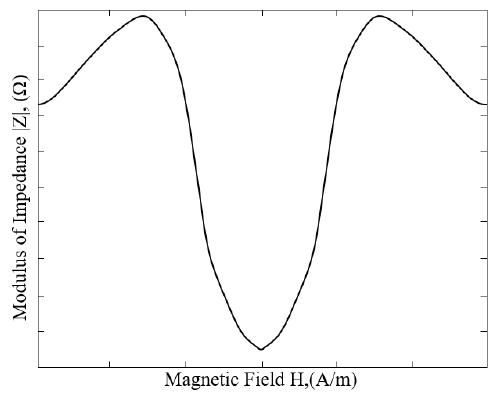
Figure 2. Typical curve of the GMI effect of the amorphous wire.